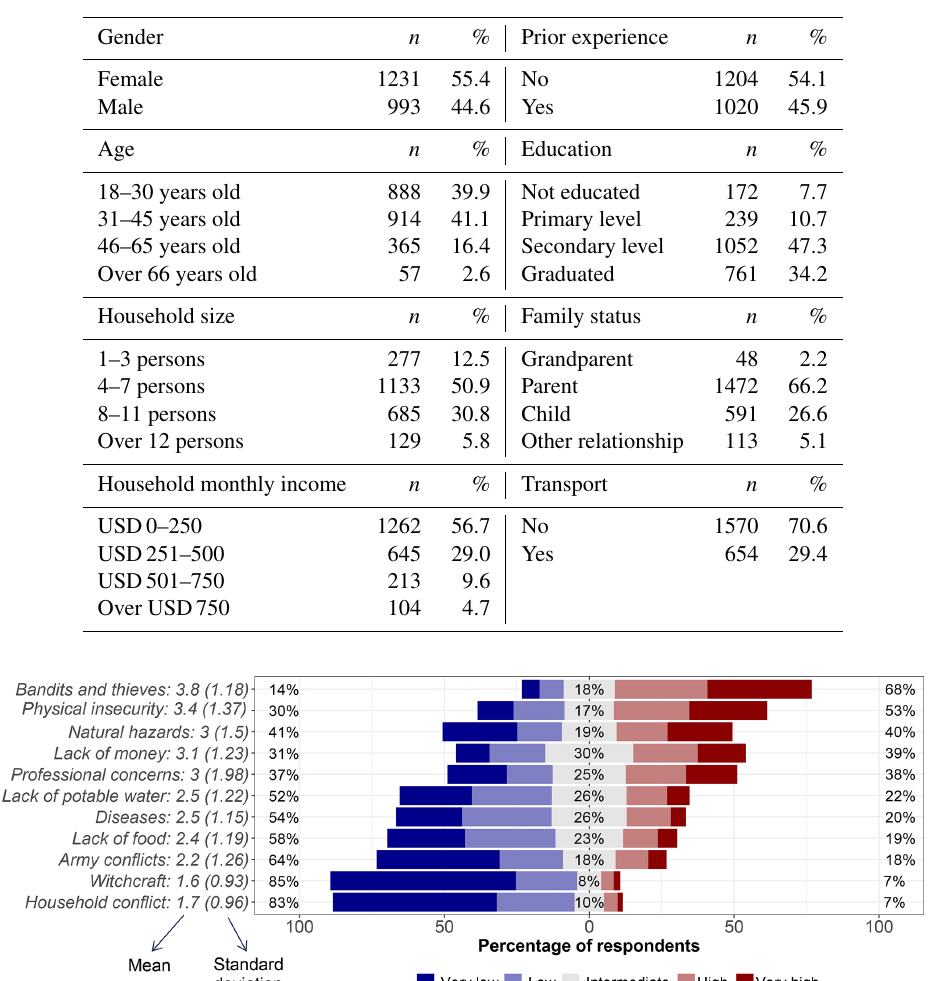
Figure 3. Level of perceived likelihood of hazards as a potential source of harm to the respondent. After converting the Likert scale into a numerical scale (very low = 1 to very high = 5), the mean indicates the average perceived level of likelihood of occurrence of each hazard with a range of variation that the mean may have (standard deviation). The percentages on the right represent the proportion of those who perceived a high to very high likelihood of hazard occurrence and impact. The percentages on the left represent the proportion of those who perceive this likelihood to be low and very low. The middle percentages represent the proportion of the population with an intermediate perception level of the